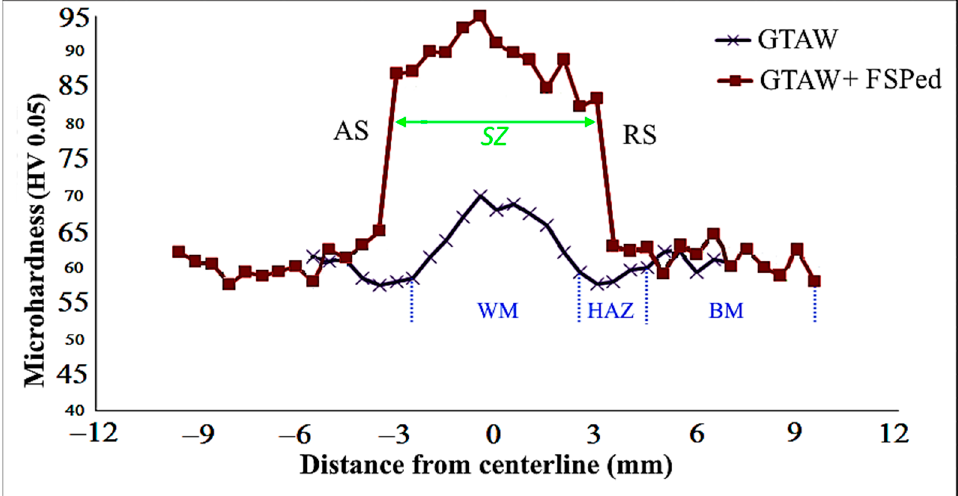
Figure 10. Microhardness pro fi les of the central cross-sectional zones of the unprocessed and fric- tion-stir-processed welds. stir-processed